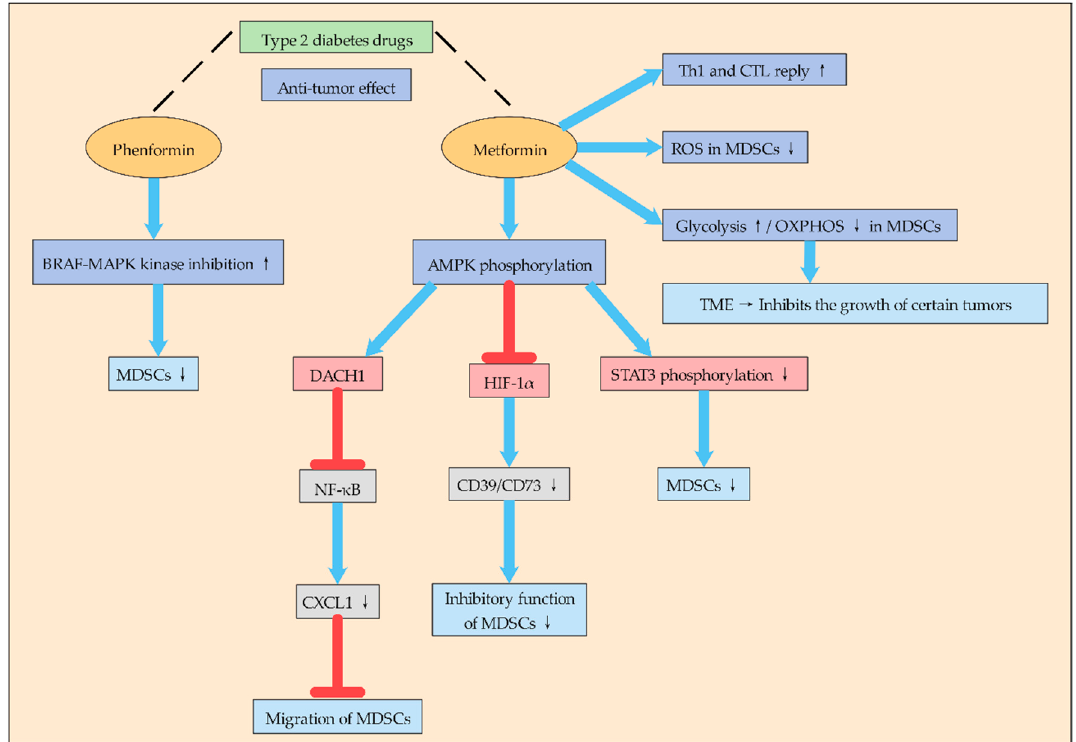
Figure 2. Type 2 diabetes drugs can be used to treat tumors through MDSCs. Type 2 diabetes drugs Phenformin and Metformin can regulate the metabolism of MDSCs through different mechanisms and thus reduce the immunosuppressive function of MDSCs, thus playing an anticancer effect. Phenformin can inhibit MDSCs by enhancing the inhibitory effect of BRAF-MAPK kinase. Metformin can induce the response of Th1 and CTL, reduce ROS in MDSCs, and improve glycolysis and reduce oxidative phosphorylation, thus transforming the TME into a state that inhibits the growth of some tumors. Metformin inhibits MDSCs mainly by activating AMPK phosphorylation and then regulating DACH1, HIF-1 α , STAT3, etc.